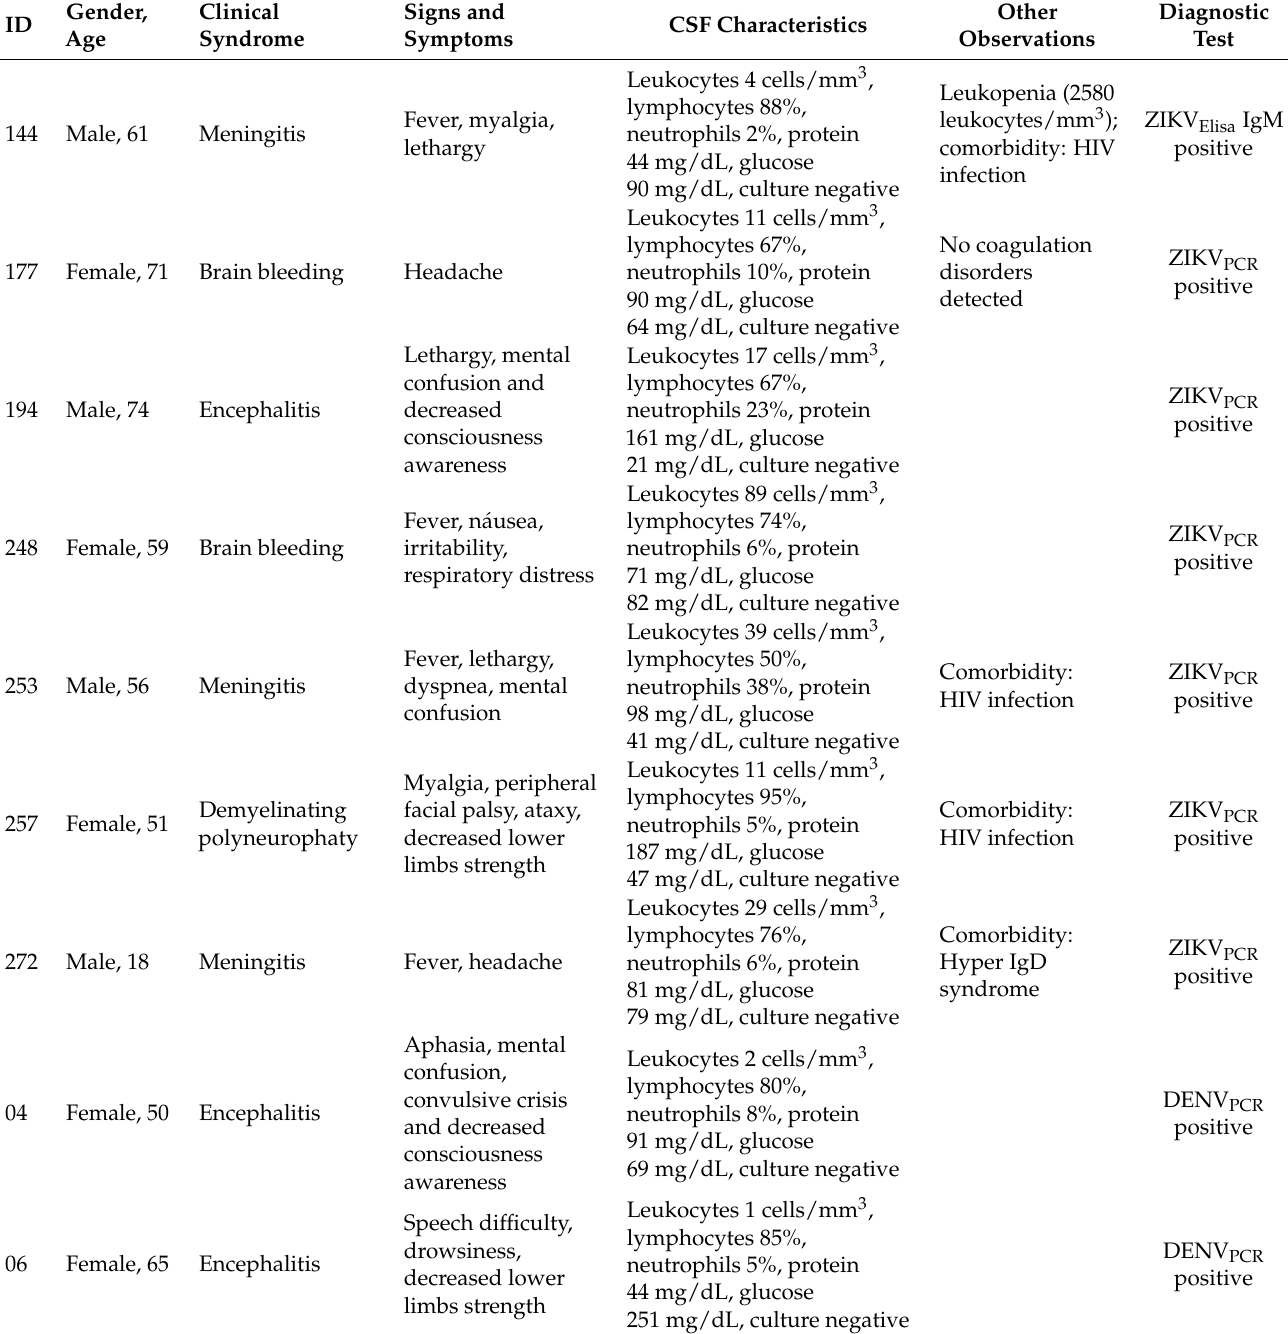
Table 1. Clinical data from the positive patients in CSF